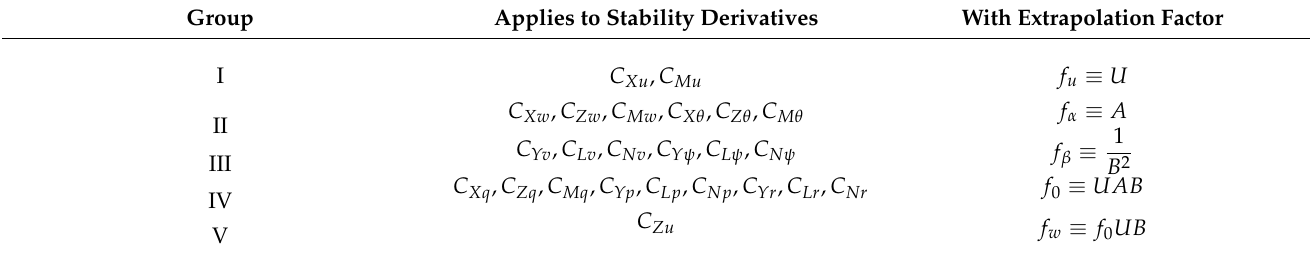
Table 1. Extrapolation factors for stability derivatives comparing flight conditions 1 ( V 1 , α 1 , β 1 )